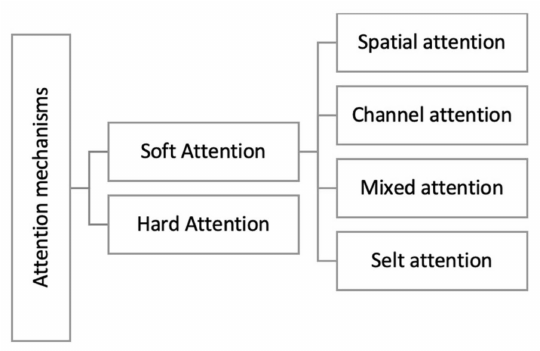
Figure 12. Subgroups of Attention models.